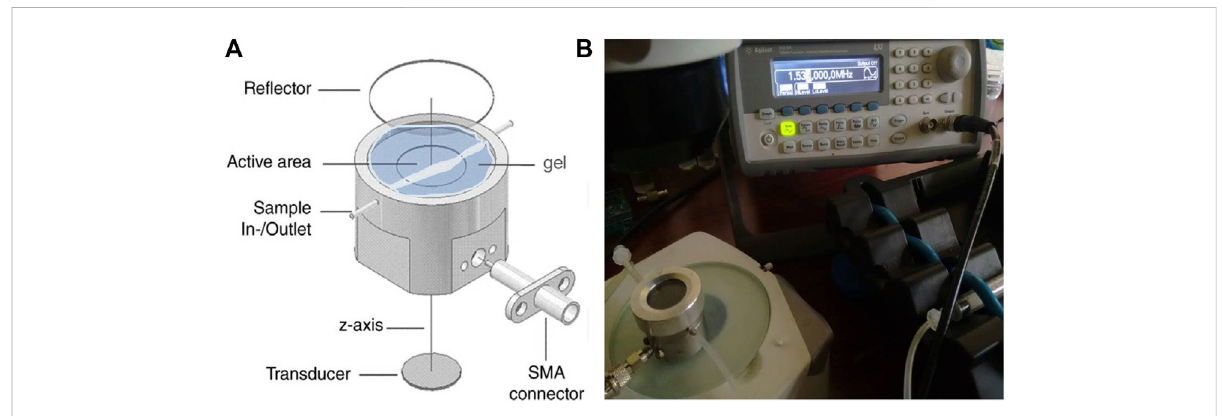
FIGURE 2 (A) Schematicdiagramofthesetup usedtoperformtheacoustophoreticmanipulation; (B) channelizedpathformedbythesuspension fl owing between the chamber inlet and outlet, surrounded by the aqueous-based gel